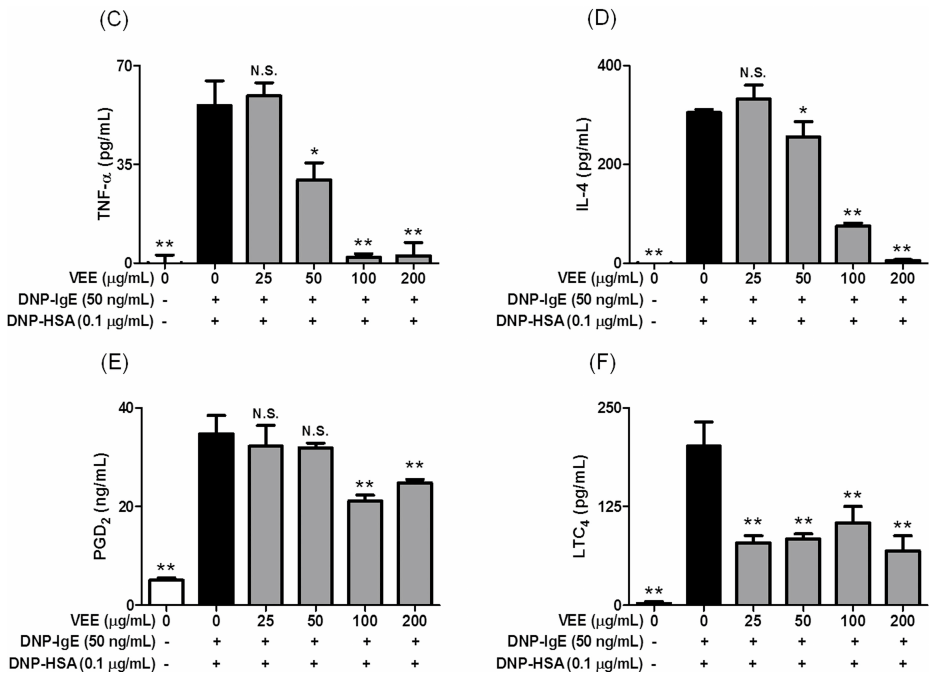
Figure 2. Effects of VEE on degranulation, inflammatory mediators and cell viability in IgE/Ag-activated RBL-2H3 cells. IgE-sensitized RBL-2H3 cells were preincubated with VEE (0–200 μ g/mL) for 1 h prior to antigenic challenge. β -Hexosaminidase activity, the amounts of IL-4, TNF- α , PGD 2 , and LTC 4 , and cell viability were determined as described in the Materials and Methods section. The data are expressed as the mean ± SD values of triple or octuplex determinations. N.S., not statistically significant; * p < 0.05